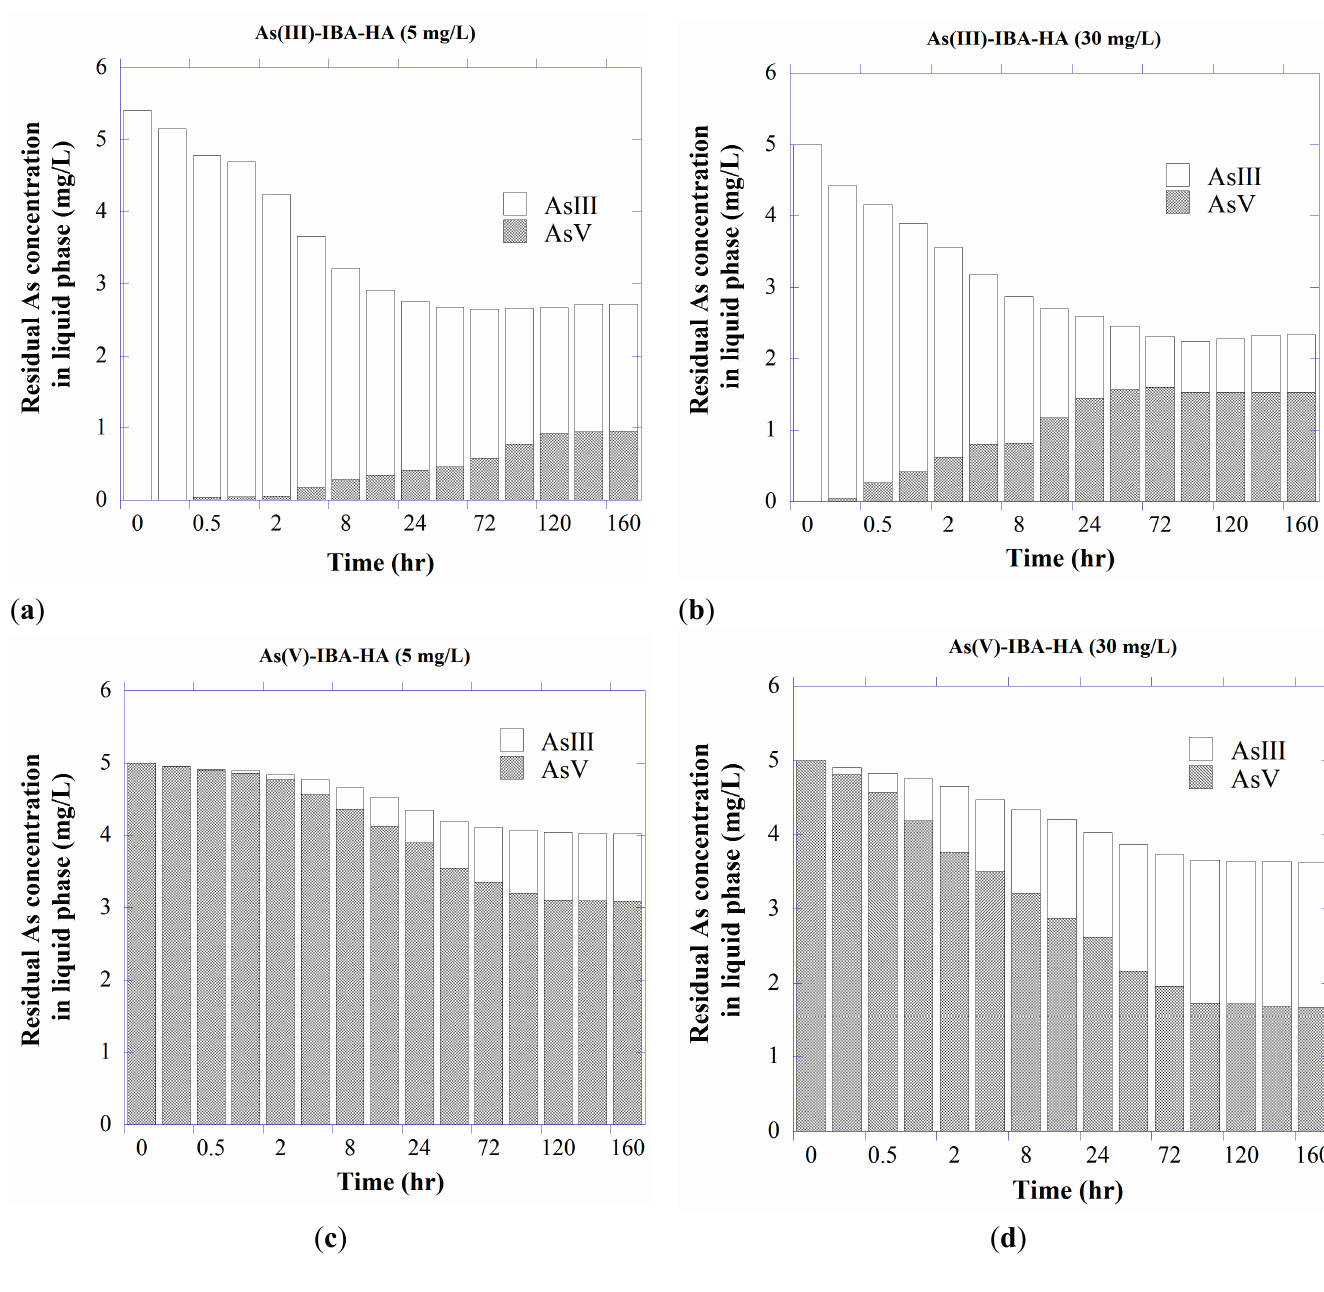
Figure 3. Redox transformation of ( a , b ) As(III) and ( c , d ) As(V) in liquid phase of the ternary As-IBA-HA system with initial As concentration of 5 mg/L at pH